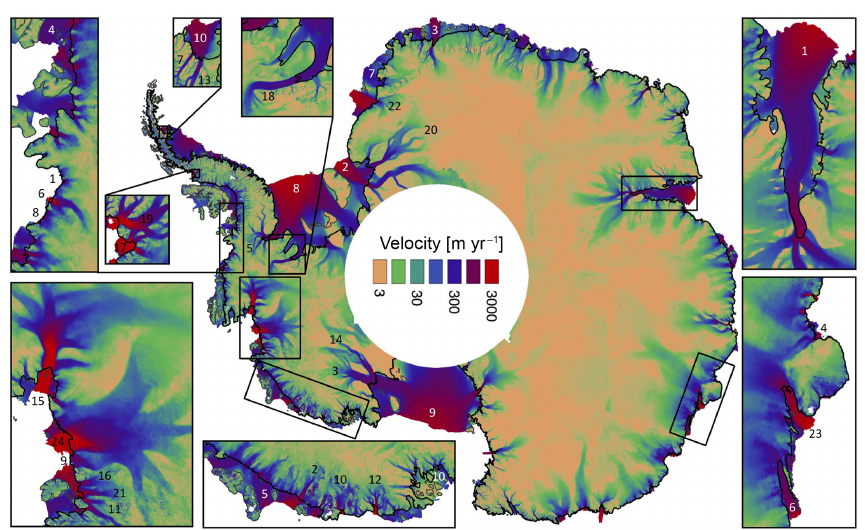
Figure 8. 2015 Antarctic ice sheet surface velocities shown in log scale determined from feature tracking of >200000 Landsat image pairs. Glacier and ice streams discussed in text labeled with black numbering: (1) Alison, (2) Berry, (3) Bindschadler, (4) Bond, (5) Evans, (6) Ferrigno, (7) Flask, (8) Fox, (9) Haynes, (10) Hull, (11) Kohler, (12) Land, (13) Leppard, (14) MacAyeal, (15) Pine Island, (16) Pope, (17) Prospect, (18) Rutford, (19) Seller, (20) Slessor, (21) Smith, (22) Stancomb-Wills, (23) Totten, and (24) Twaites. Ice shelves labeled with white numbering: (1) Amery, (2) Filchner, (3) Fimbul, (4) George VI, (5) Getz, (6) Moscow U., (7) Riiser-Larsen, (8) Ronne, (9) Ross, (10) Scar Inlet, and (10) Sulzberger.